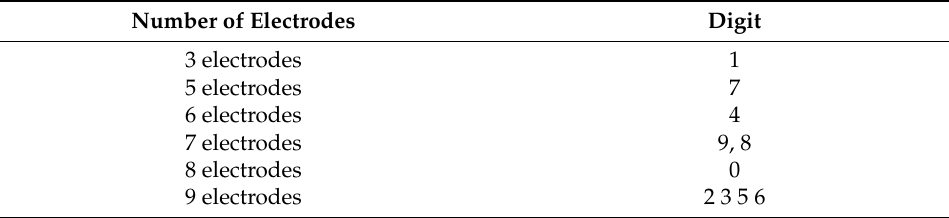
Figure 9. Signals generated by input digit 9. Table 1. Digital pattern classification.